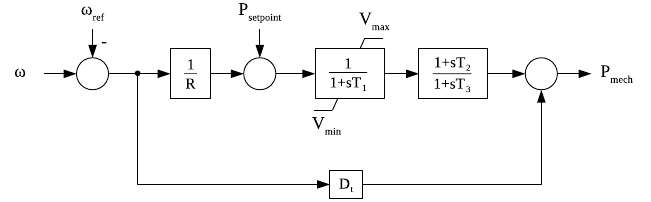
Figure 4. Block diagram of PSS controller.